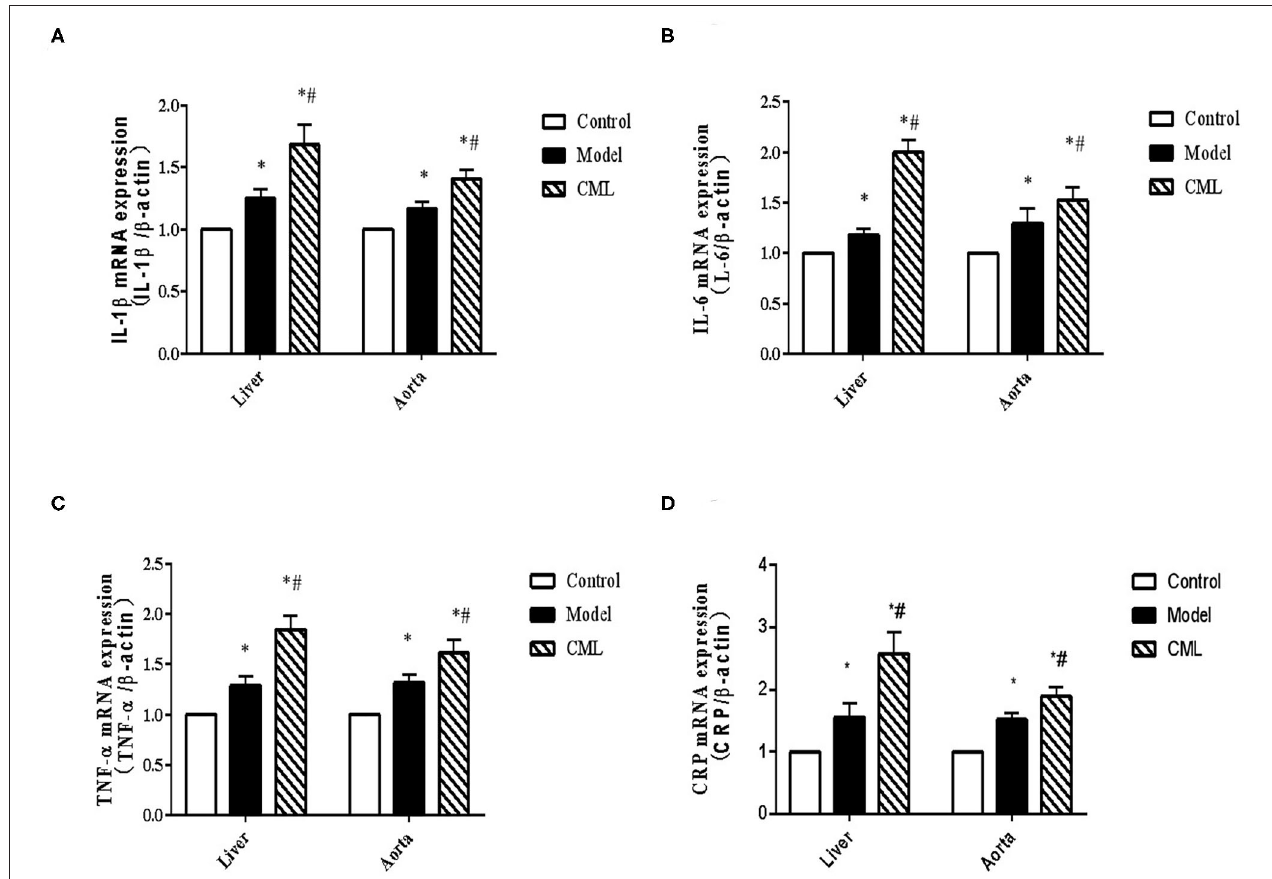
FIGURE 6 | CML promotes the expression of pro-inflammatory cytokines in liver and blood vessels of ApoE − / − mice (A–D) Detection of IL-1 β , IL-6, TNF- α , CRP mRNA expression levels in liver and aorta by PCR. * P < 0.05, compared with control group; # P < 0.05, compared with model group.